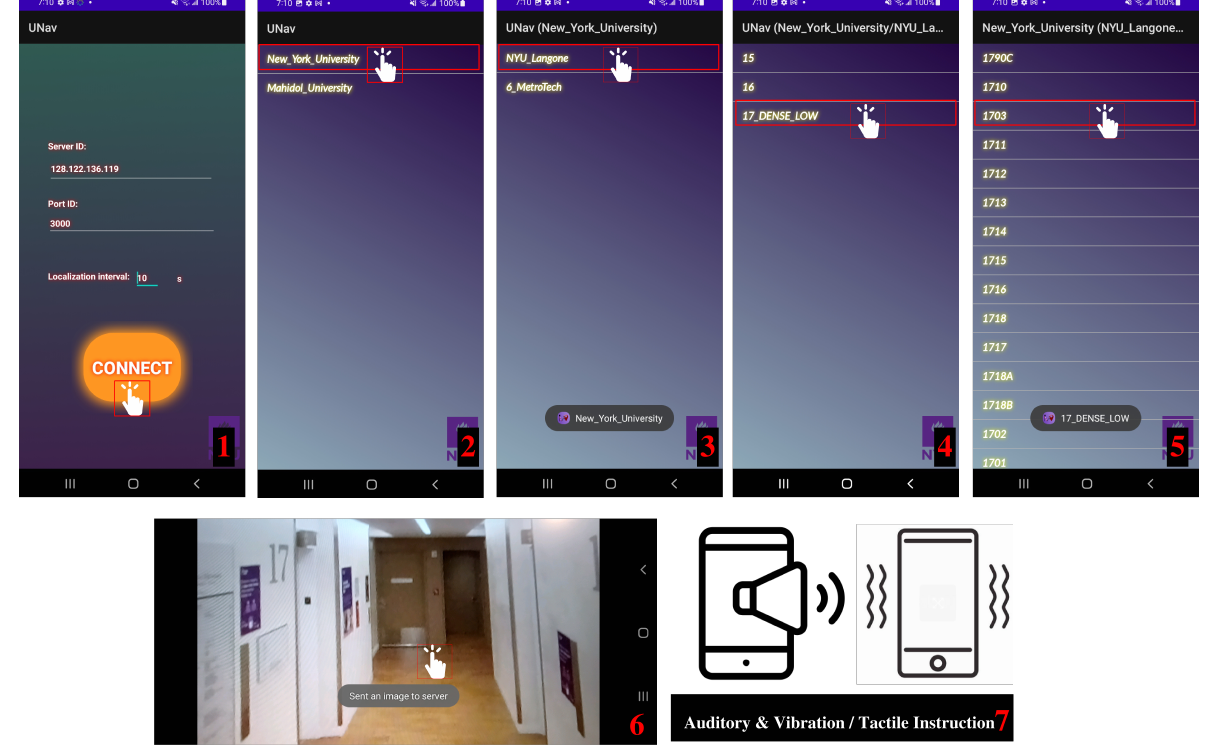
Figure 7. Android application. There are seven steps to any trip initiation. The first step (1) is to enter the server ID, port ID, and the time interval between two image captures/server instructions (the end user can use the default settings without any changes). The next four steps (2–5) are a cascade of linked choices that must be completed for the user to select the desired destination, inclusive of place, building, floor, and room. This procedure may be completed with either verbal or tactile input. Once the destination has been selected, the camera will turn on and the user will need to wait for the capturing time interval of touch the screen to take and send an initial query image to the server (Step 6). The server will then send back navigation instructions via auditory or vibration signals (Step 7). After multiple iterations of Steps 6 and 7, the user will reach the desired